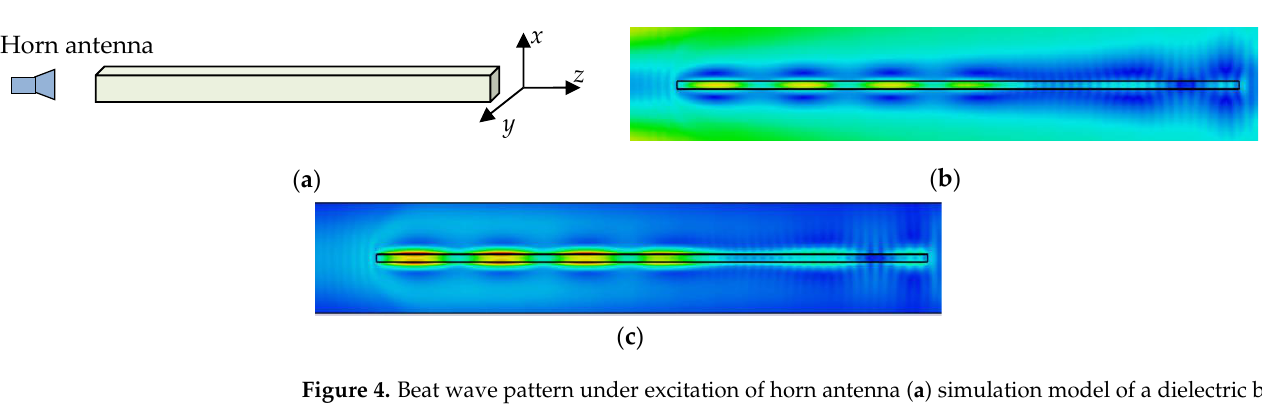
Figure 3. Beat wave pattern along a lossy dielectric bar.